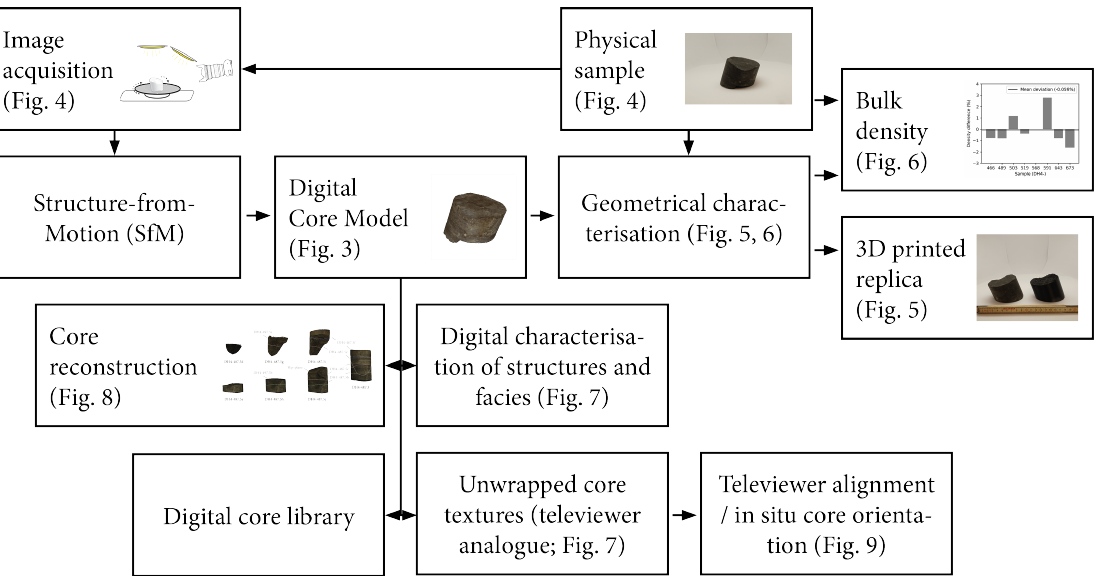
Figure 2. Flowchart of the developed workflow to generate digital (drill) core models (DCMs) and associated